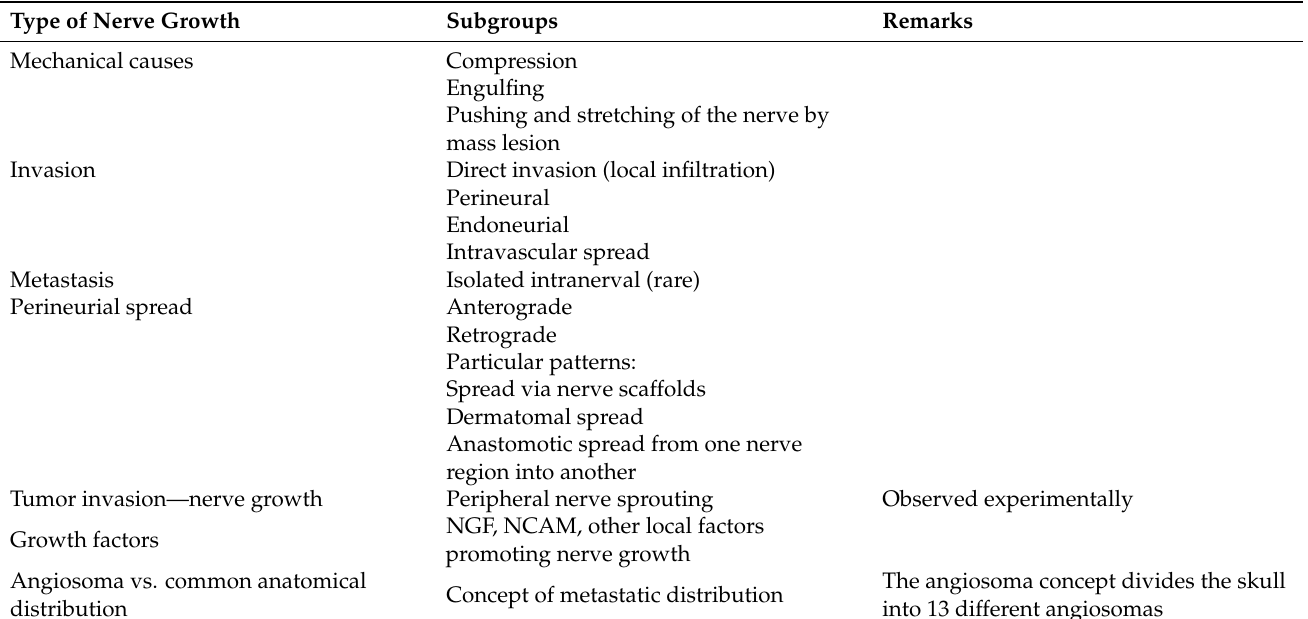
Table 1. Mechanisms of nerve invasion: several mechanisms of nerve involvement are known and vary from mechanical lesions to different oncological patterns. Abbreviations: NGF, Nerve growth factor; NCAM, Neural Cell Adhesion Molecule. Reproduced with Permission from Grisold W, Grisold A. Cancer around the brain. Neurooncol Pract. 2014; 1(1): 13–21. doi:10.1093/nop/npt002